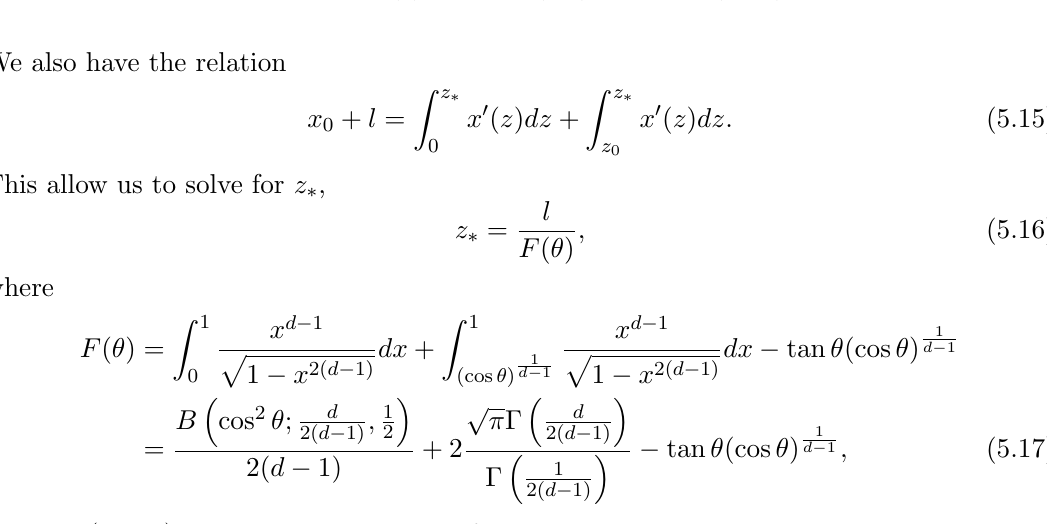
Figure 4 . F ( (cid:18) ) for d = 3 (left) and d = 4